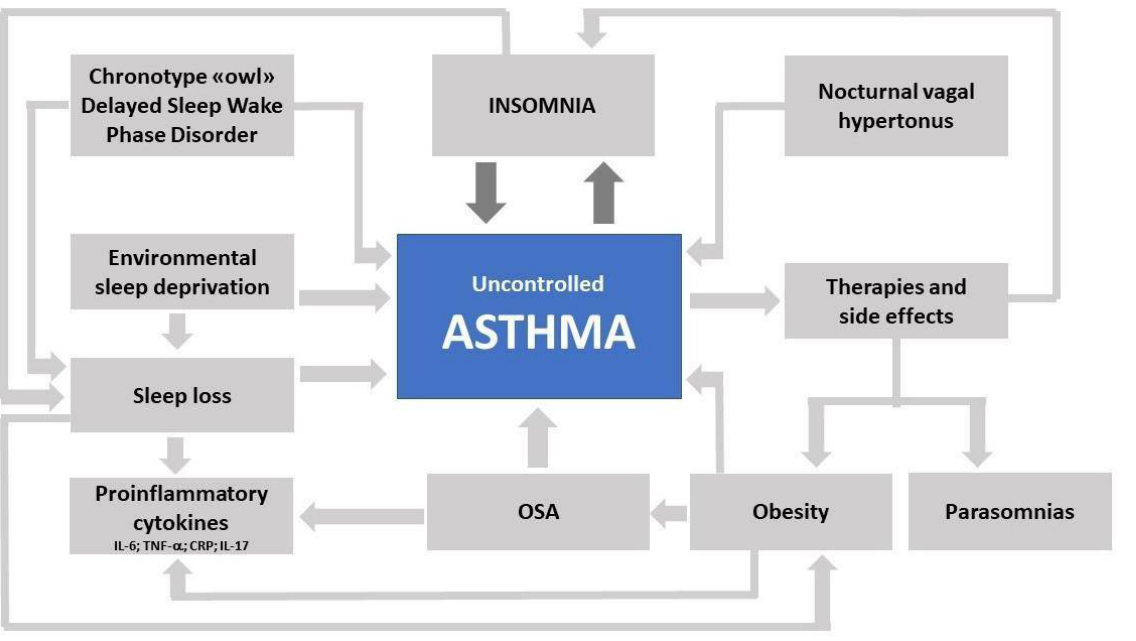
Figure 1. The effects of uncontrolled asthma on sleep disorders.